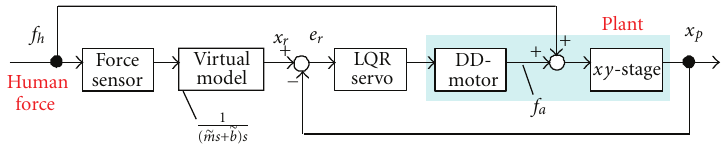
Figure 6: Block diagram of virtual internal model